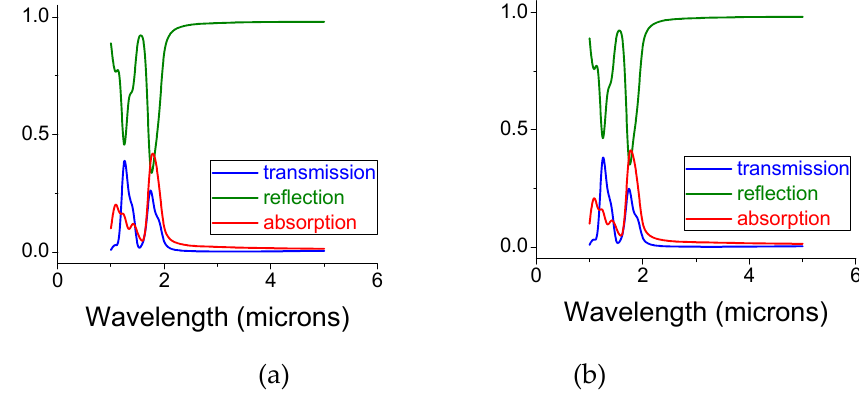
Figure 10. Intensity coefficients for transmission, reflection, and absorption for an un-shifted bi-layer screen filled with silica colloids in MgO. The structure was held at ( a ) room temperature and ( b ) at 850 °C. The opening and disk diameters are 0.5 and 0.7 microns, respectively, and the gap size and the sphere diameter are 0.5 microns. The thickness of each copper mono-screen is 0.1 microns and the diameter of the colloids equals the gap size. No significant change is noted in the electromagnetic coefficients for the 'cold' and 'hot' cases.